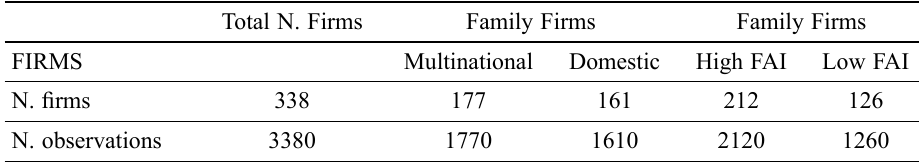
Total N. Firms Family Firms Family Firms FIRMS Multinational Domestic High FAI Low FAI 338